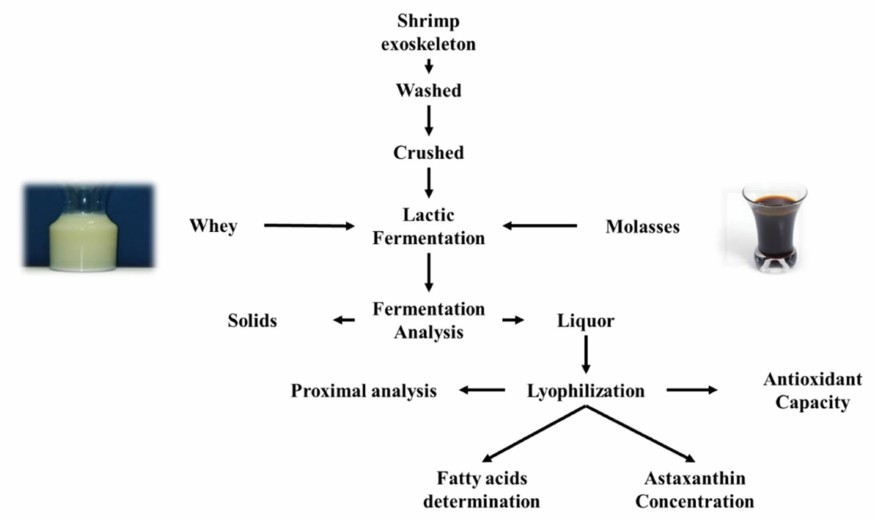
Figure 1. Process diagram to produce the lyophilized liquor from fermented shrimp